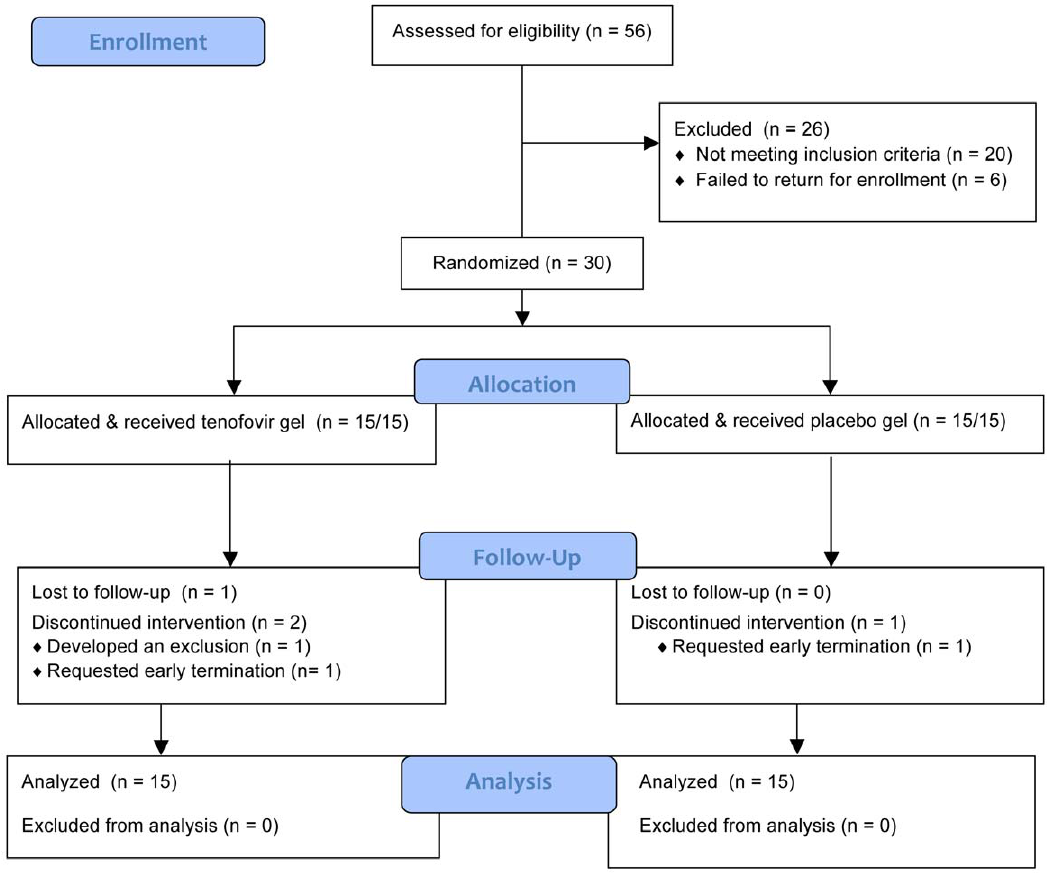
Figure 1. Trial profile.